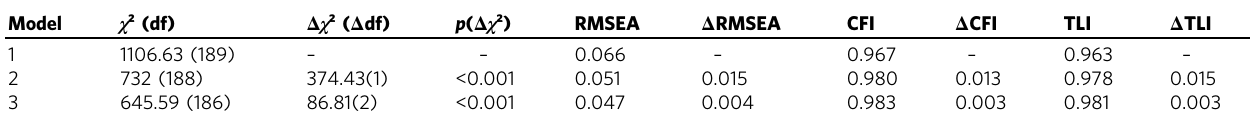
Table 2 Comparison of fi t indexes for the three models considered. Model